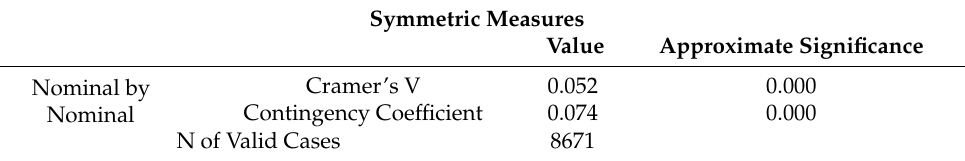
Table 8. Strength of dependence between variables. Source: own